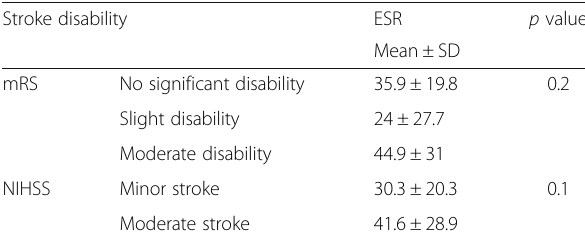
Table 3 Comparison of the serum level of ESR in different disability scales Stroke disability